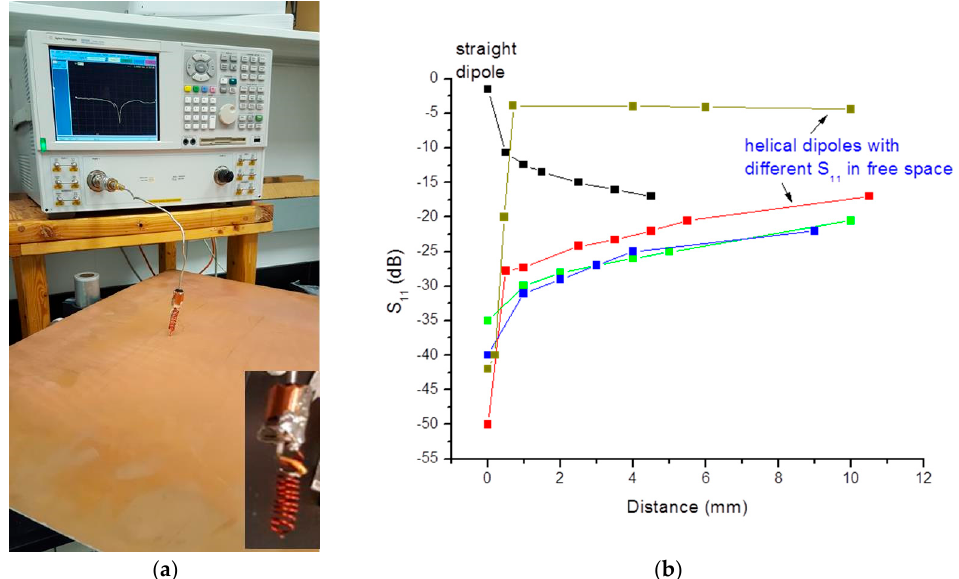
Figure 3. ( a ) Measurements of S 11 of the fabricated helical antenna resonant at 2.45 GHz near a large copper plane. The micro-positioning stage is located below the copper plane. The inset shows a photo of the antenna; ( b ) Tuning of the fabricated helical antennas resonant at 2.45 GHz via measurements of S 11 as a function of distance from the large copper plane. The tuning parameter is the tapping point of a feeding coaxial line. The red, green and blue curves correspond to di ff erent positions of the tapping point on the same antenna. Behavior of a conventional dipole antenna is presented for a